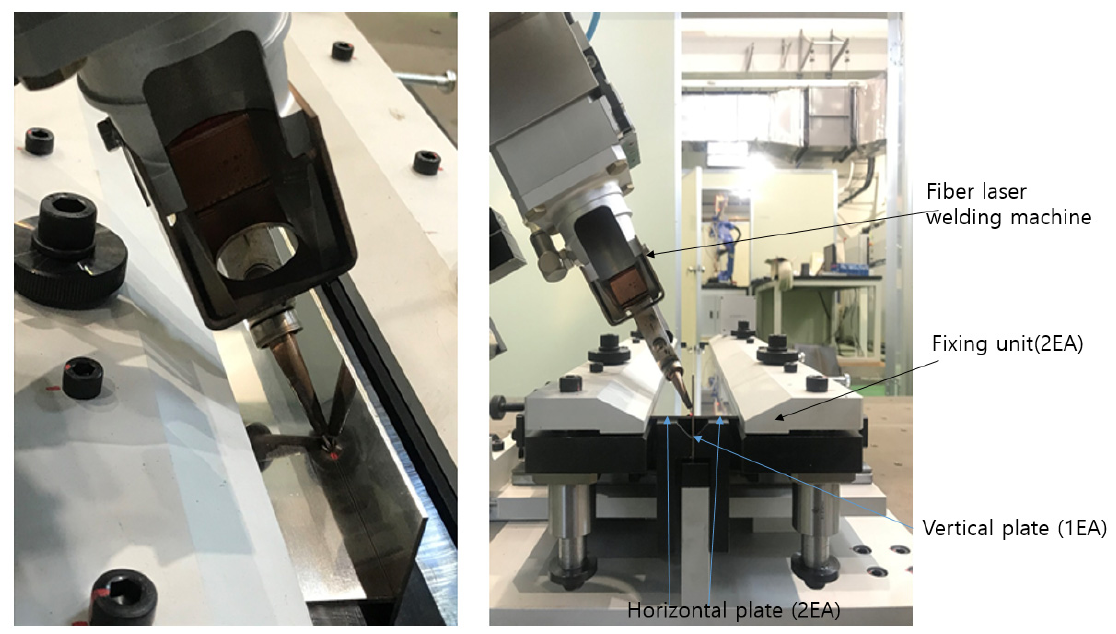
Figure 2. Shape of laser welding jigs.